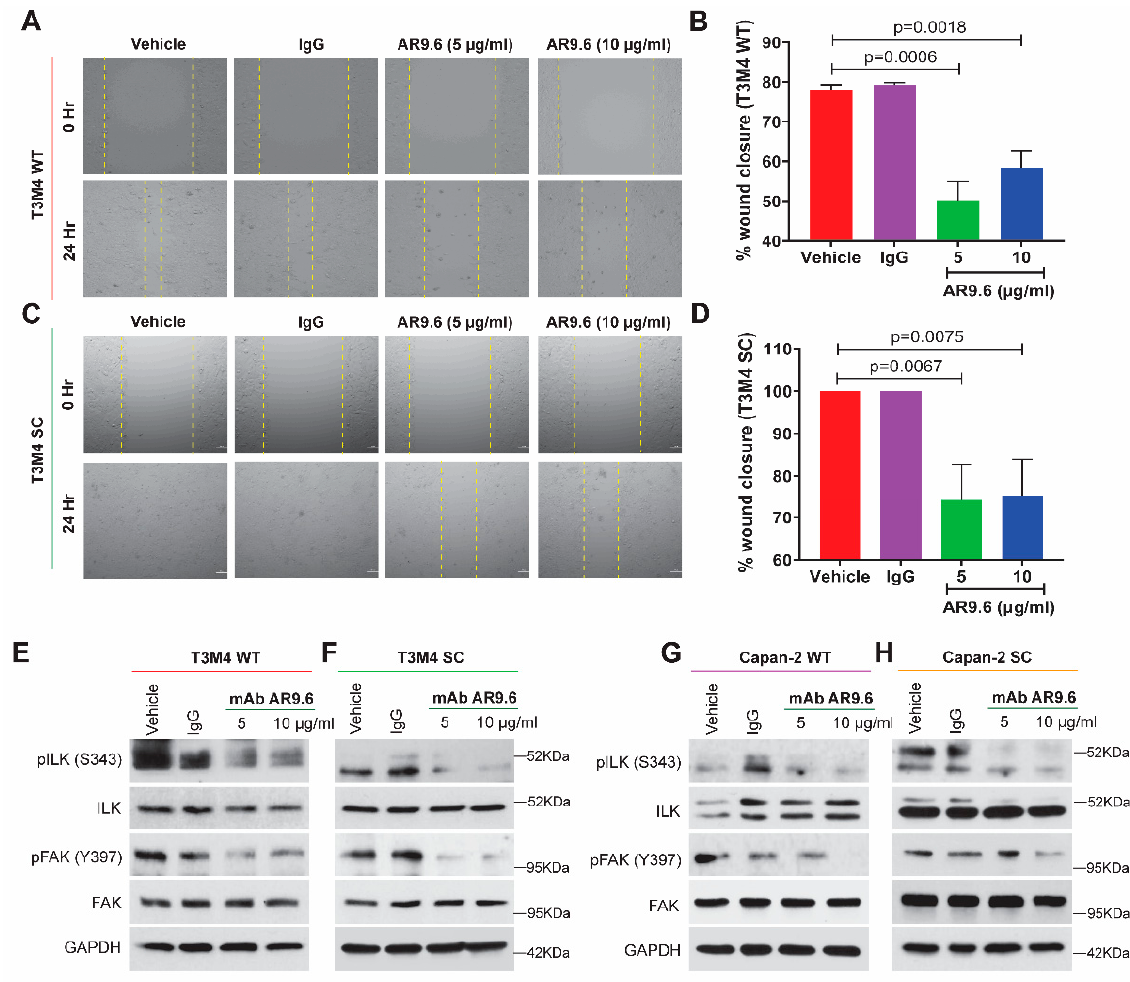
Figure 5. Treatment with anti-MUC16 AR9.6 antibody alleviates PDAC cell migration via the ILK- FAK axis. Cells were treated with anti-MUC16 AR9.6 antibody (5 µg/mL and 10 µg/mL); controls: untreated (complete media) and isotype-control (5 µg/mL murine IgG) for all of the following: wound healing assay with ( A ) T3M4 WT cells; ( B ) quantification of percent wound closure in T3M4 WT cells; ( C ) T3M4 SC cells; ( D ) quantification of percent wound closure in T3M4 SC cells; p < 0.05 is considered statistically significant. Western blot analysis for pILK (S343), total ILK, pFAK (Y397), total FAK in ( E ) T3M4 WT; ( F ) T3M4 SC; ( G ) Capan-2 WT; ( H ) Capan-2 SC cells; loading control: GAPDH.